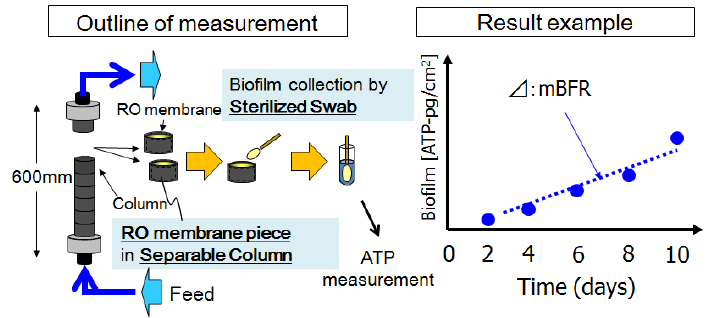
Figure 6. Biofouling monitoring index.